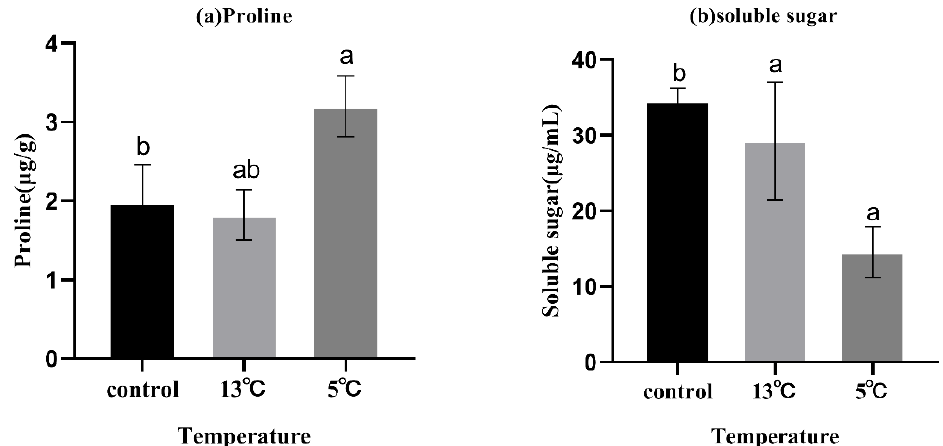
Figure 2. Effect of upwelling on the proline and soluble sugar content in the leaves of K. obovata. ( a ) Proline; ( b ) soluble sugar. Values are presented as mean ± SD, and bars with different letters indicate significant differences ( p < 0.05).